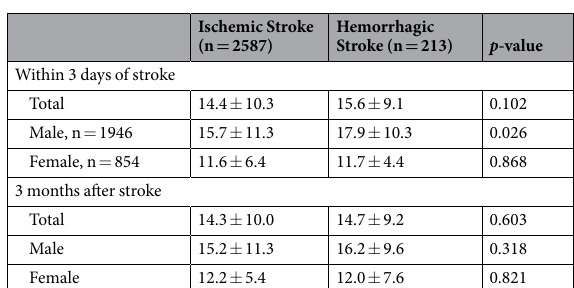
rate of recurrence was significantly higher in patients with higher levels of tHcy (third quartile) than in patients with the lowest levels of tHcy (first quartile) (unadjusted HR: 1.51; 95% CI: 1.04–2.19; p = 0.032). This association remained significant for patients with high tHcy levels (fourth quartile) as compared to patients with low tHcy levels (first quartile), even after adjusting for age, sex, smoking status, LDL-C level, hsCRP level, and ApoB/ApoAI ratio and the presence of hypertension, type 2 diabetes mellitus, coronary artery disease, and obesity (adjusted HR: 1.76; 95% CI: 1.11–3.08; p = 0.031) (Table 5). After analyzing the data by type of ischemia, we found that patients with large-artery atherosclerosis ischemia with high levels of tHcy (third or fourth quartile) had a significantly higher risk of recurrent ischemic stroke than patients in the lowest quartile (unadjusted HR: 1.75, 95% CI: 1.08–2.82; p = 0.021 or unadjusted HR: 1.65, 95%